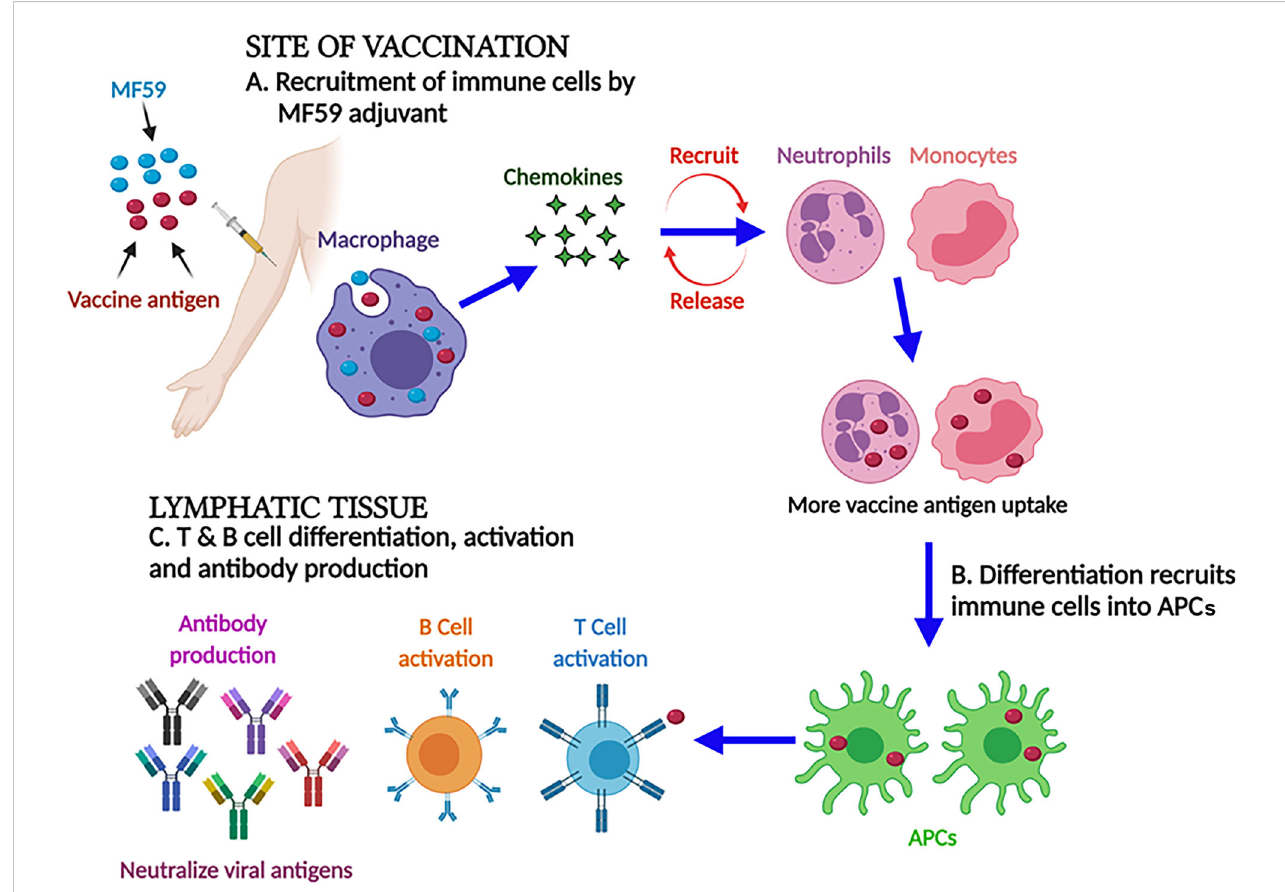
FIGURE 2 MF59 adjuvant and its mechanism of action. At the injection site, MF59 adjuvant-activated macrophages secrete the chemokines that stimulate and recruit the immune cells. Differentiation converts immune cells into antigen-presenting cells to activate B and T cells to impart strong humoral and cellular immune